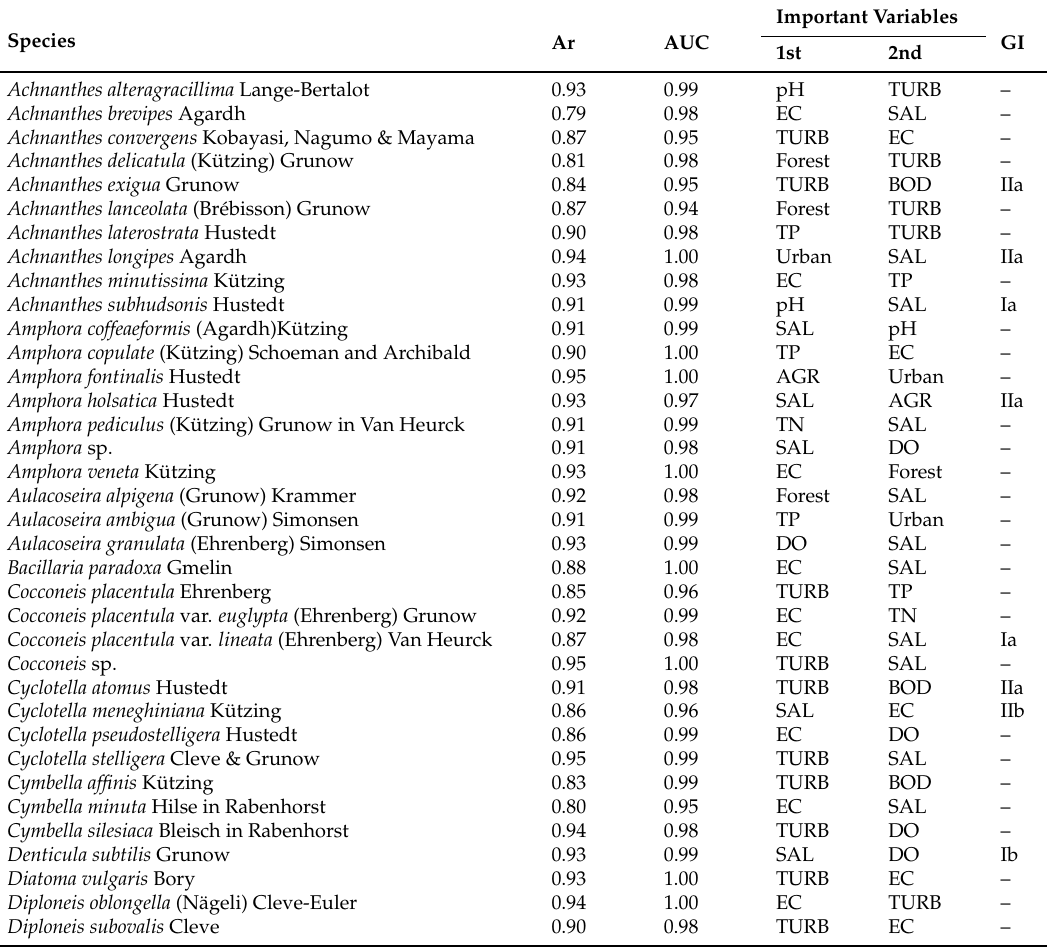
Table 4. List of epilithic diatoms with the first and second most important variables predicting species appearance by a random forest model in Korean estuaries between 2012 and 2014. Ar: accuracy rate, AUC: area under the curve, GI: group